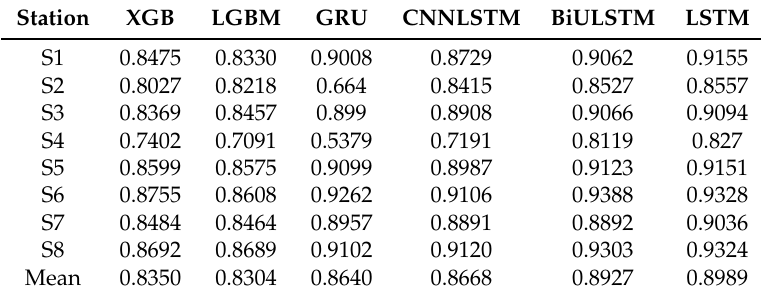
Table 7. Models results for R .